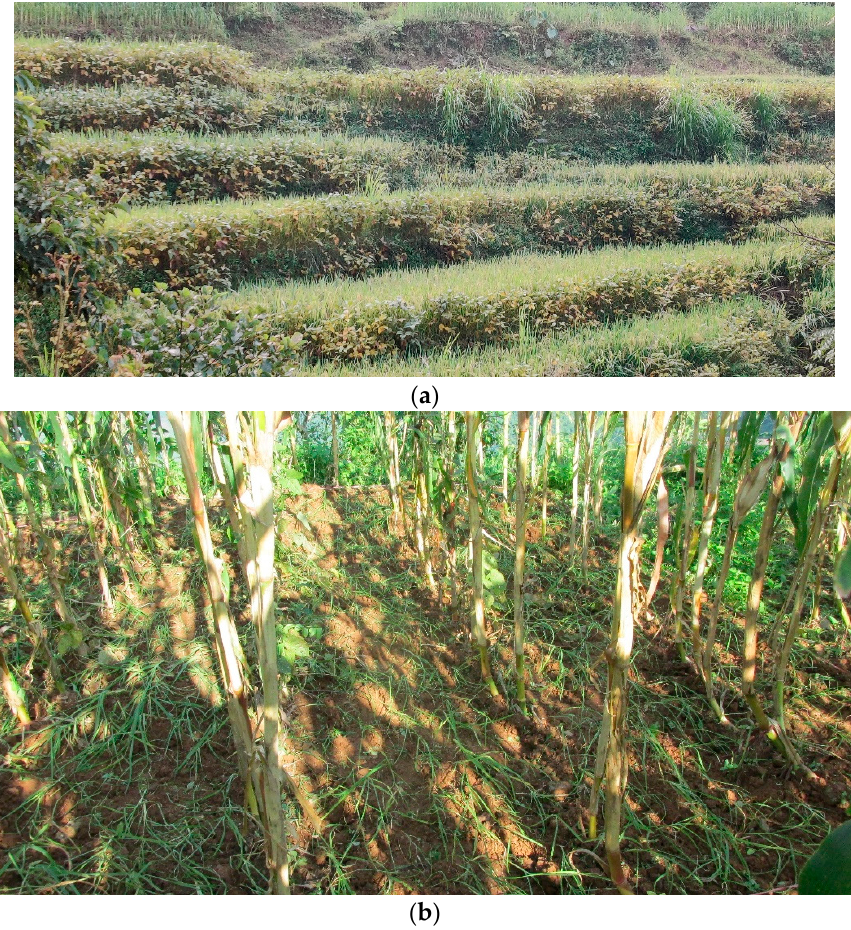
Figure 1. ( a ). Intercropping of blackgram and rice ( Oryza sativa L.) on step farm in Nepal, ( b ). Corn intercropped with ginger ( Zingiber officinale L.).